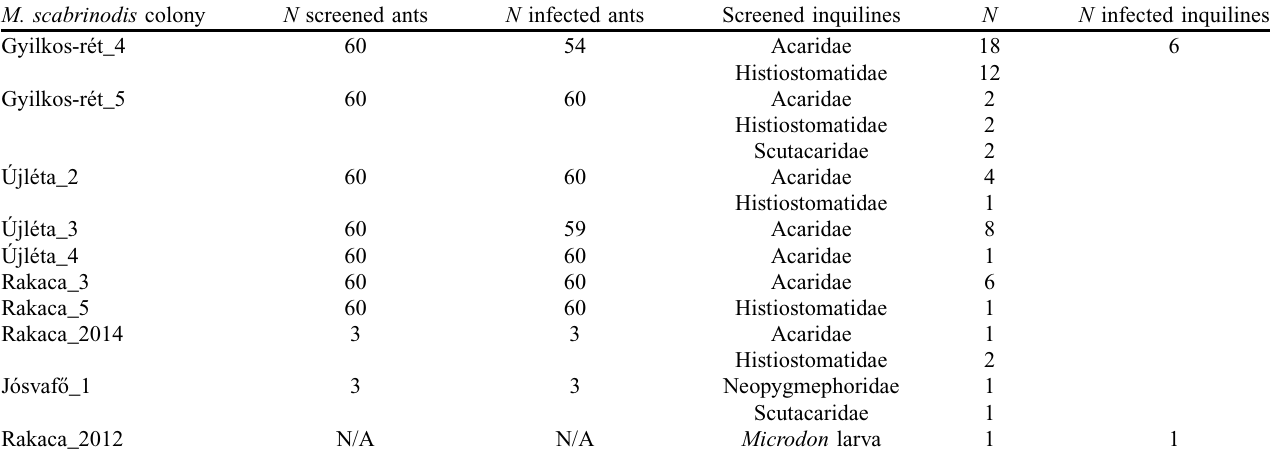
Table 1. Ants and ant colonies collected in Hungary, in the period 2012–2015, with indication of number of screened and infected ants and